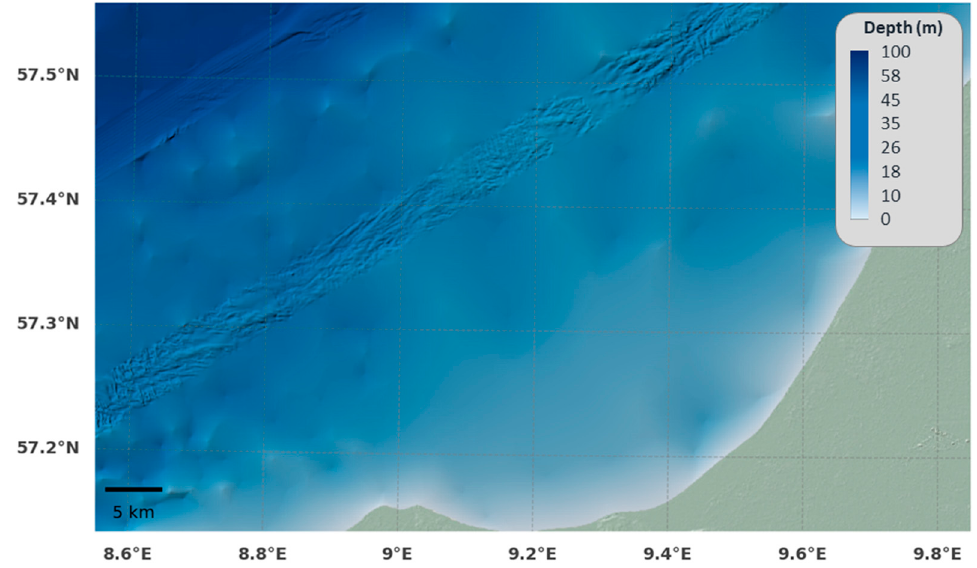
Figure 9. Bathymetry of an area of about 50 km offshore the city of Hirtshals (North Jutland, Denmark). The maximum model depth in the area is ~100 m. The oblique strip with detailed bathymetry is derived from a MBES source. The Global Multi-Resolution Topography (GMRT) version 4.0 is shown in the background.